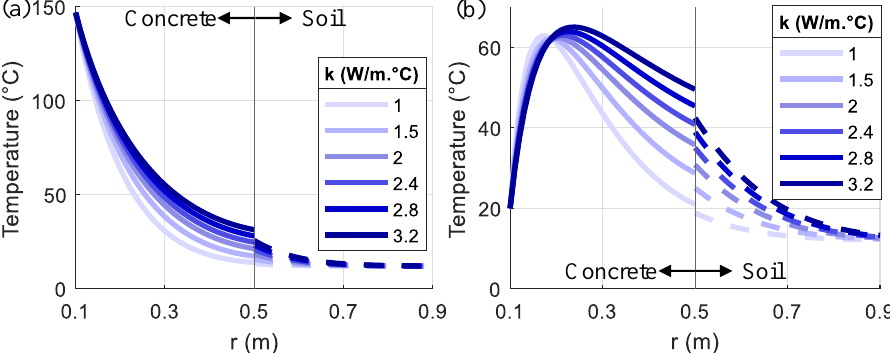
Figure 17. Temperature distribution in the first loading cycle for different k at: ( a ) 19:00; ( b ) 7:00 (end of the loading cycle).